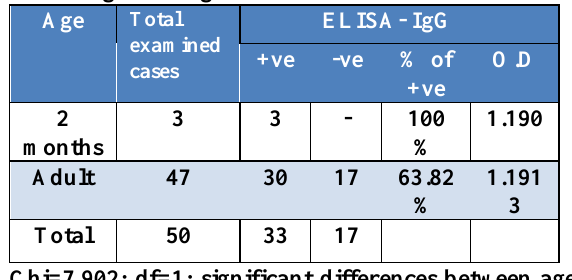
Table, 2: Seropositive of ELISA- IgG in stray cats according to the